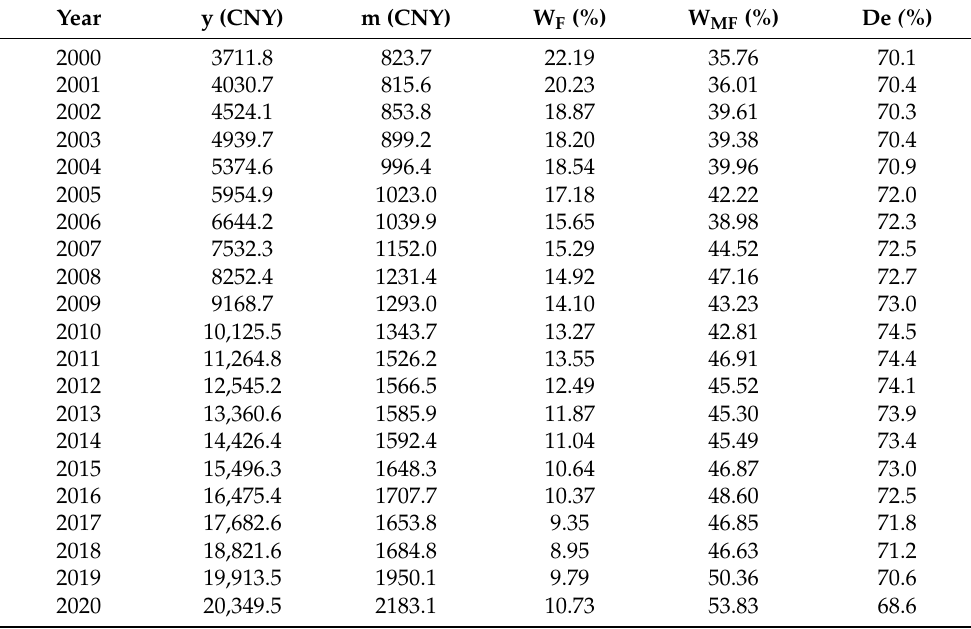
Table 2. Per capita income and food expenditure in China between